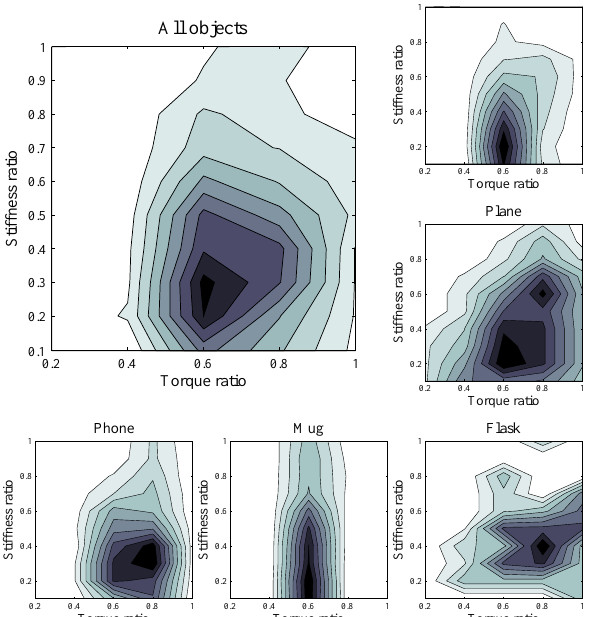
Fig. 3. THE EFFECT OF HAND DESIGN PARAMETERS ON Figure 3. The e ff ect of hand design parameters on the likelihood THE LIKELIHOOD OF OBTAINING A STABLE GRASP. A of obtaining a stable grasp. a darker color means a higher number DARKER COLOR MEANS A HIGHER NUMBER OF STABLE of stable grasps. GRASPS.